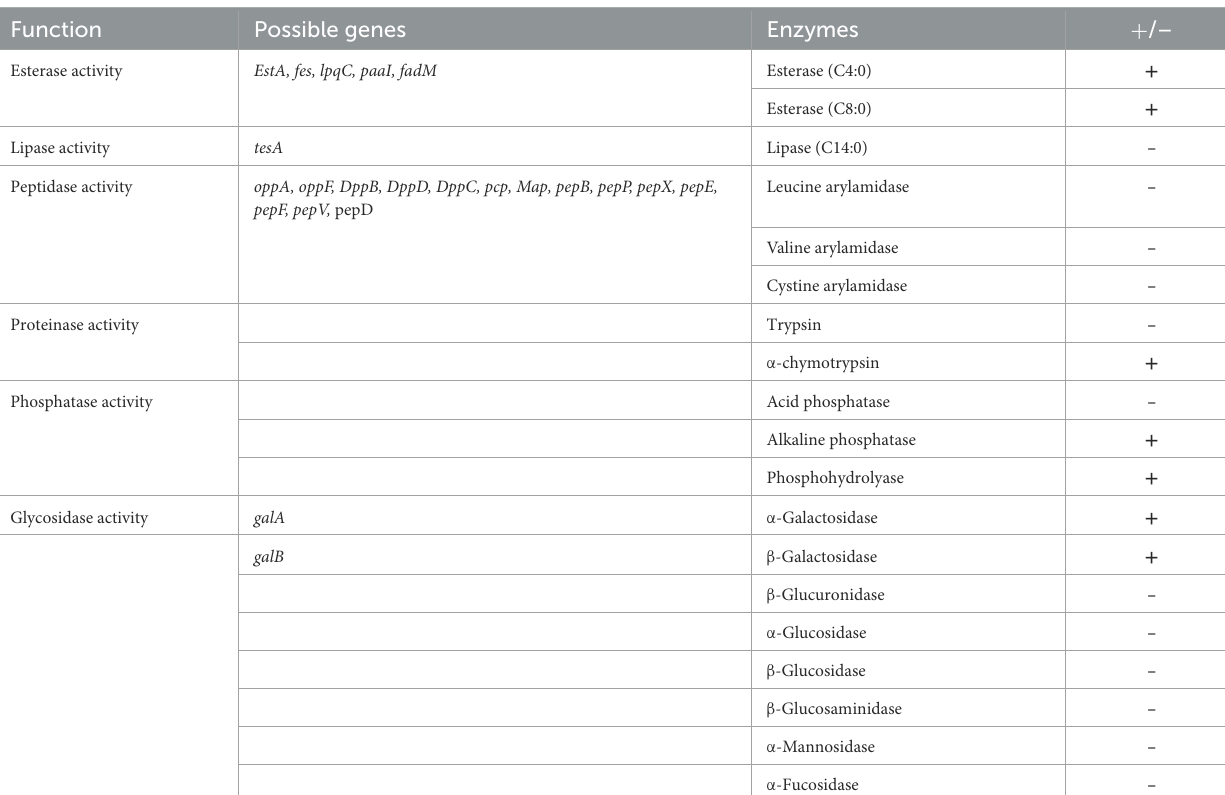
TABLE 2 Semi-quantitative assay of enzyme activities of Renuspore ® using API ZYM kit ( n = 3), where + indicates the presence and—indicates the absence of enzymes. Function